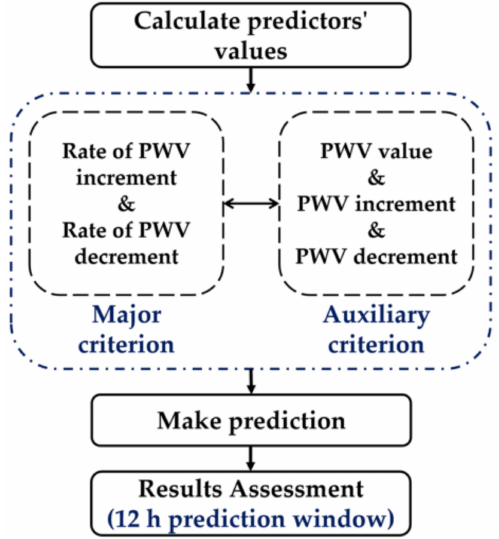
Figure 7. Flowchart for model